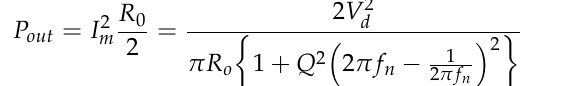
Table 2. Parameters used for the simulation.